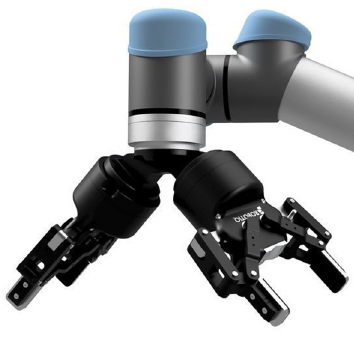
Fig. 4. End of arm tooling